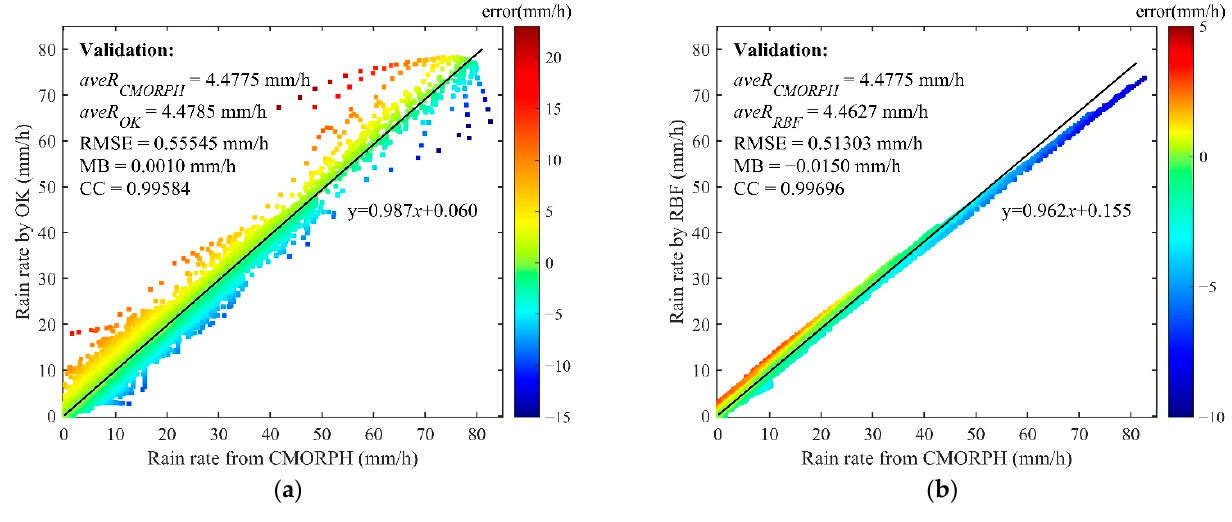
Figure 9. The results of the joint network of ESLs and HMLs retrieving all rain rates from real rainfall fields: ( a ) Comparison of rain rates retrieved by the joint network of ESLs and HMLs based on the OK algorithm with the real rain rates; ( b ) Comparison of rain rates retrieved by the joint net of ESLs and HMLs based on the RBF neural network with the real rain rates.